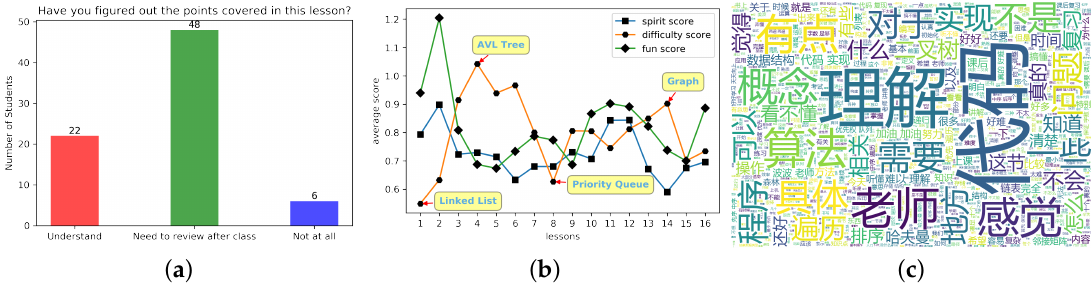
Figure 6. Data visualization of the processed data. ( a ) Multiple choice selection visualization; ( b ) Before-and-after comparison visualization; ( c ) Comments visualization via word